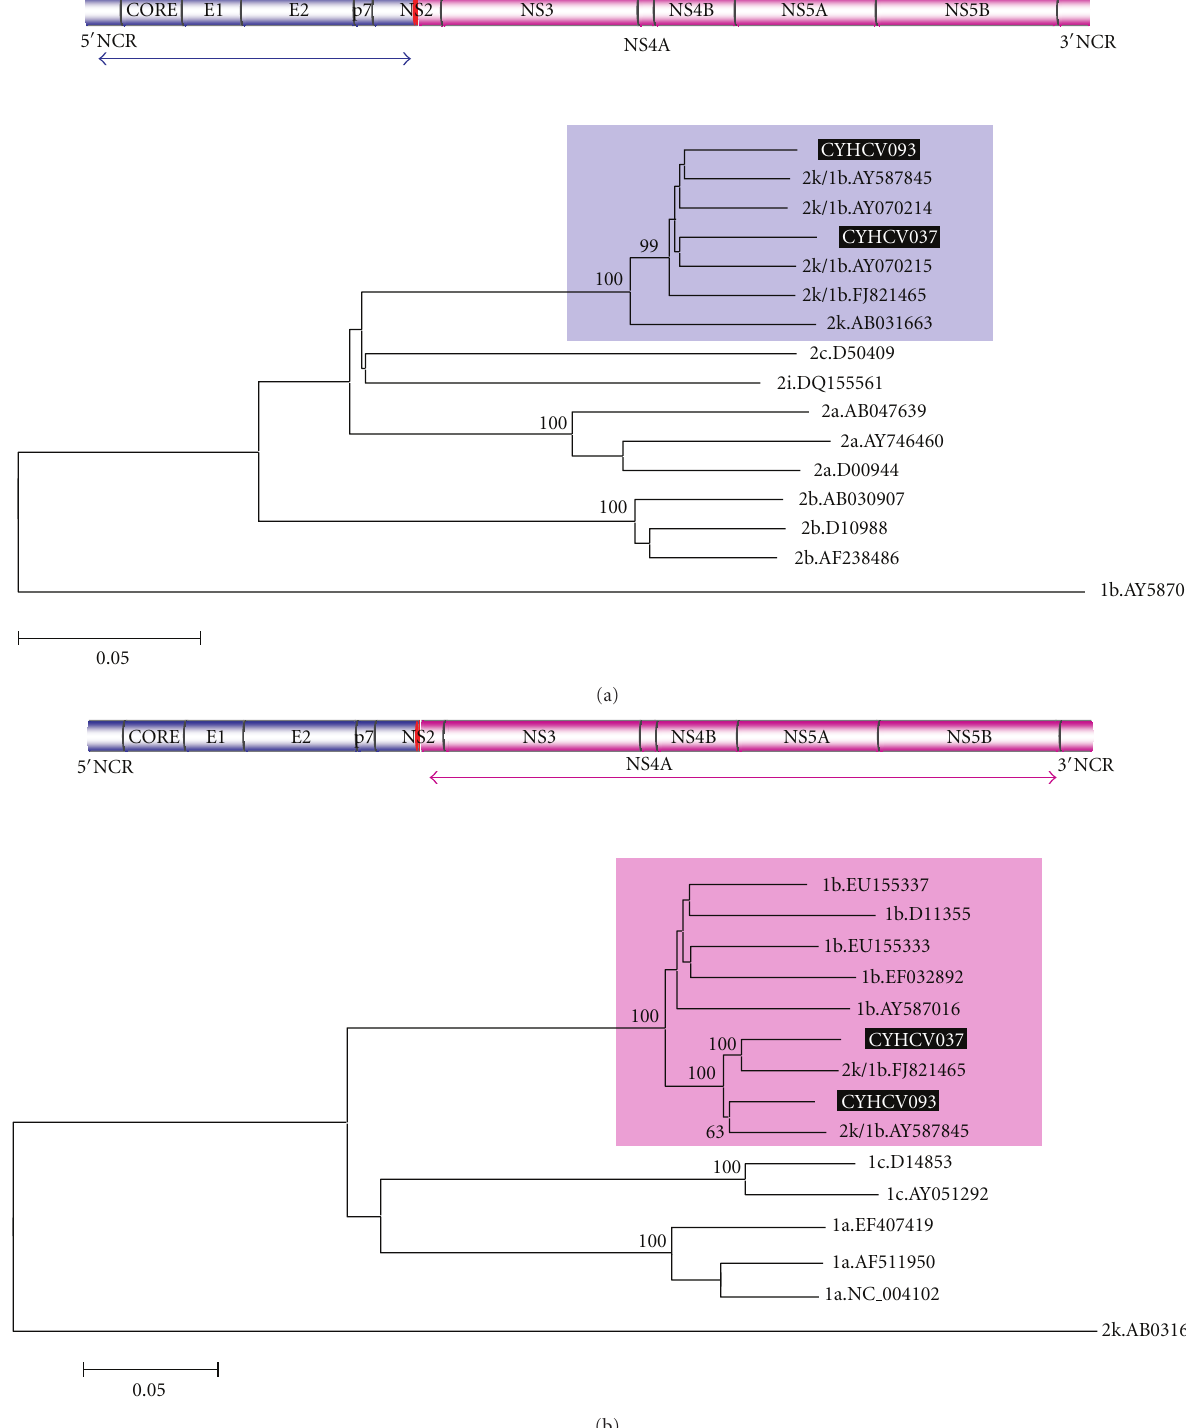
Figure 3: Neighbour-Joining trees for (a) the region 5 (cid:2) of the recombination point and (b) the region 3 (cid:2) of the recombination point, as seen by the indications on the genome maps above each tree, for the 2k/1b recombinant strains identified in this study (highlighted in black), other 2k/1b sequences obtained from GenBank, and reference stains of the corresponding parental genotypes. The trees are rooted with 1b and 2k strains, respectively. Grouping can be seen within the corresponding parental subtypes and is highlighted with coloured boxes. Numbers at branch nodes indicate the percentage bootstrap support for 1,000 replicates. The scale at the bottom left of each tree indicates the divergence between any two sequences obtained by summing the branch lengths between